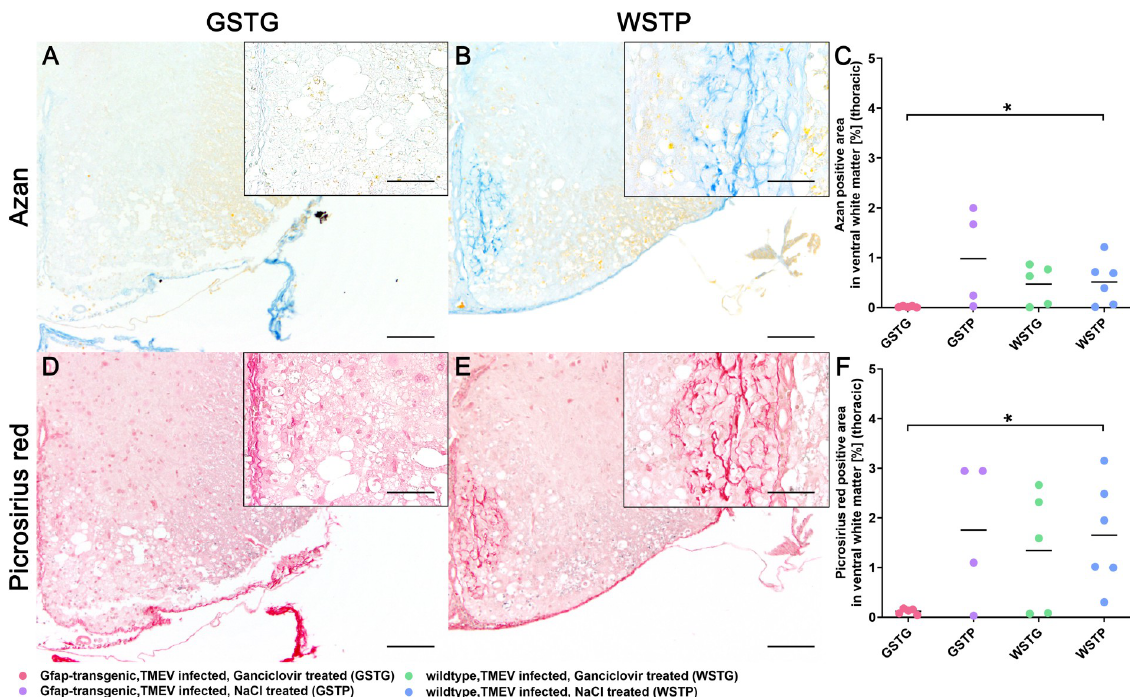
Fig 3. Impact of astrocyte depletion upon the deposition of extracellular matrix (ECM). Quantification of ECM components in the thoracic spinal cord white matter was performed using azan ( A-C ) and picrosirius red ( D-F ) staining. Accumulation of ECM components was detected intralesionally within the ventral part of the thoracic spinal cord white matter. At 77 dpi TMEV infected, ganciclovir treated, GFAP- transgenic mice (GSTG) mice ( A, D ) showed a significantly reduced azan and picrosirius red positive area, respectively, compared to TMEV infected, natrium chloride (NaCl) treated wildtype (WSTP) animals ( B, C, E, F ). Inserts visualize in more detail the intralesional accumulation of azan ( B ) and picrosirius red ( E ) labeled ECM molecules in WSTP animals compared to astrocyte depleted mice ( A , D ). For each antibody, one cross section of the thoracic spinal cord was evaluated per animal. Data are shown as scatter dot plots. The horizontal bar indicates the mean. Significant differences between GSTG and the control groups obtained by Kruskal-Wallis test followed by Mann–Whitney U post hoc tests are indicated by � , p � 0.05. Bars represent 100 μ m in overviews and 50 μ m in the